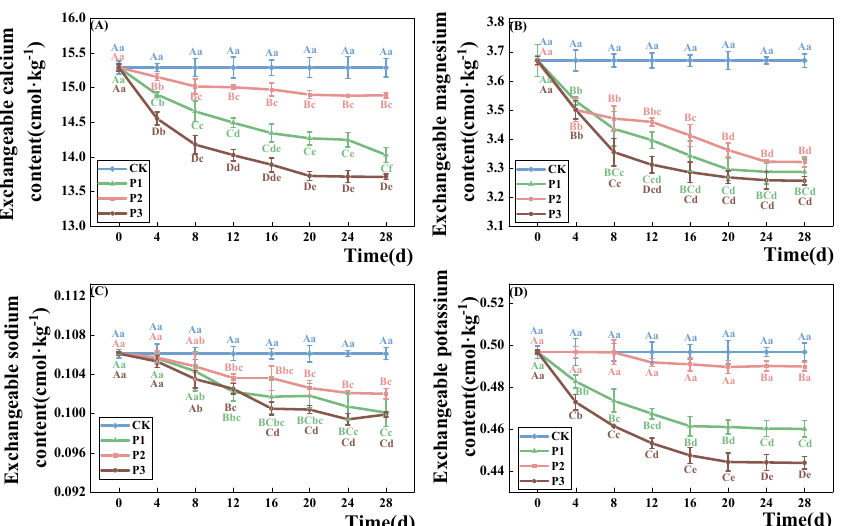
Figure 7. Soil exchangeable metal ion content with different soil bacteria. ( A ) Changes in exchange- able calcium ions in soil for various treatments; ( B ) Changes in exchangeable magnesium ions in soil for various treatments; ( C ) Changes in exchangeable sodium ions in soil for various treatments; ( D ) Changes in exchangeable potassium ions in soil for various treatments. Different capital letters denote significant differences ( p < 0.05) between treatments simultaneously based on a one − way analysis of variance and the Duncan test. Different lowercase letters denote significant differences ( p < 0.05) between different times applied to the same bacteria .